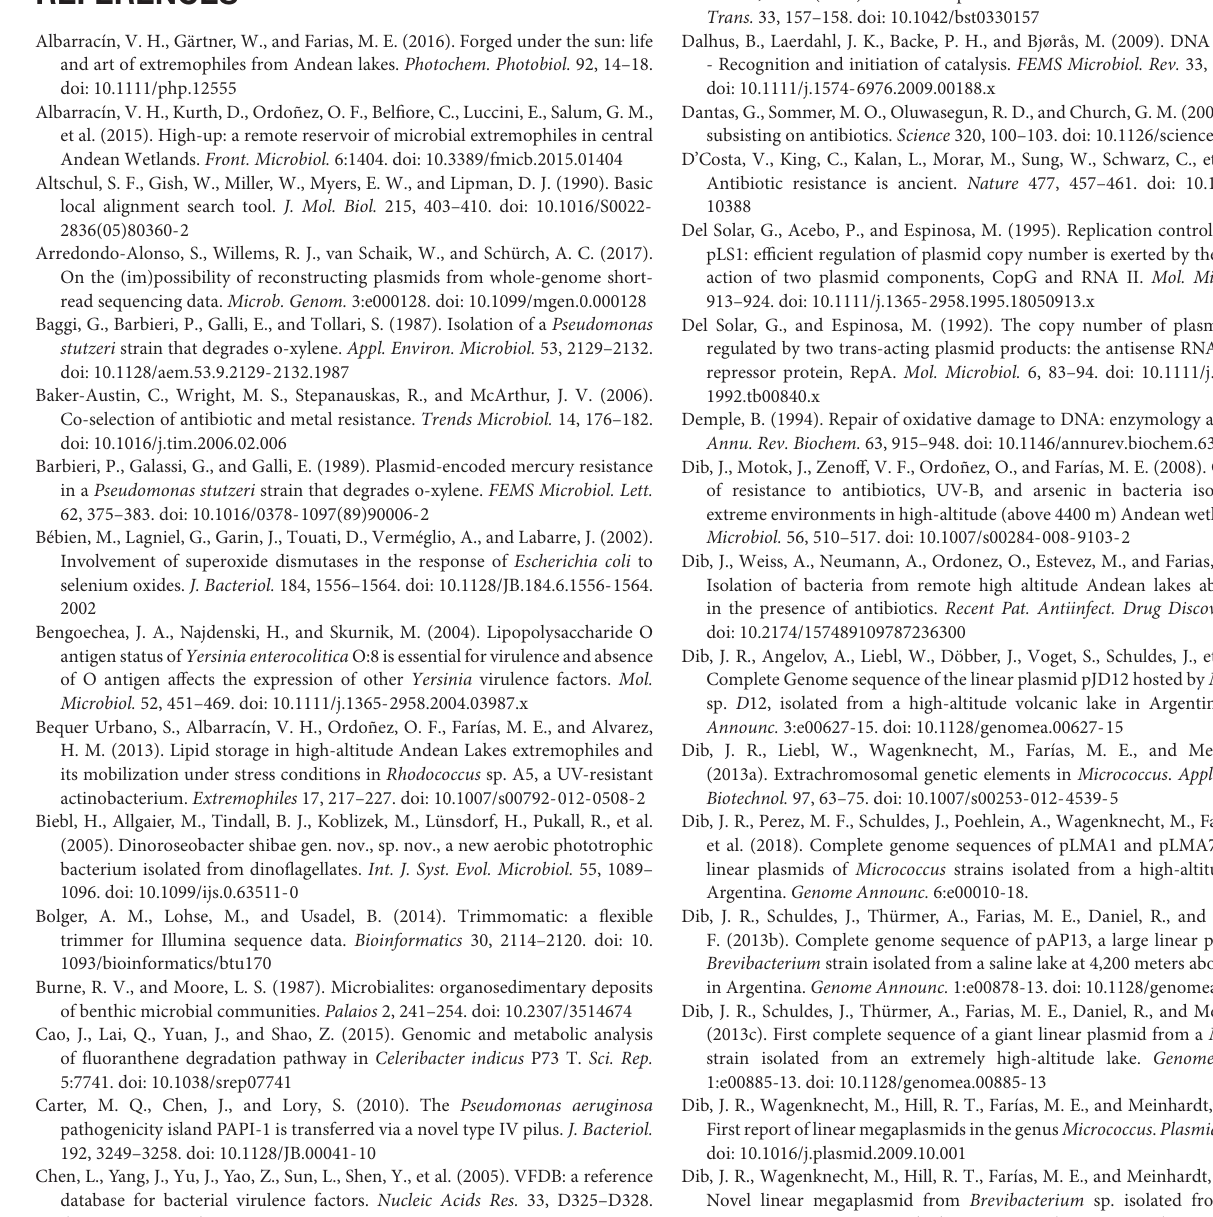
TABLE S1 | Physicochemical parameters measured in soil of Puquio de Campo